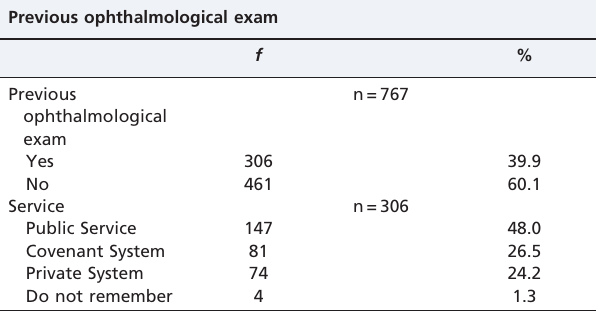
Table 2 - Previous ophthalmological evaluations of the students.